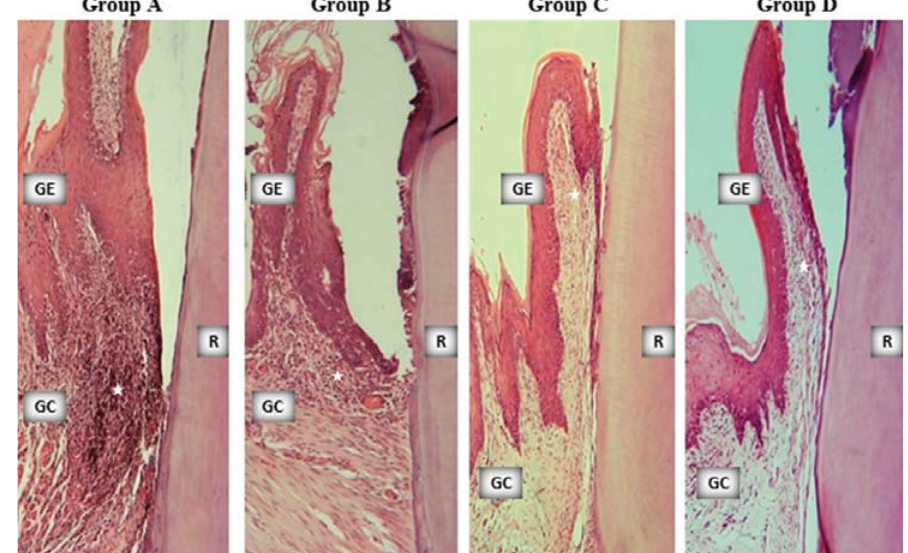
Figure 2- (cid:54)(cid:68)(cid:80)(cid:83)(cid:79)(cid:72)(cid:3)(cid:80)(cid:76)(cid:70)(cid:85)(cid:82)(cid:83)(cid:75)(cid:82)(cid:87)(cid:82)(cid:74)(cid:85)(cid:68)(cid:83)(cid:75)(cid:86)(cid:3)(cid:73)(cid:85)(cid:82)(cid:80)(cid:3)(cid:87)(cid:75)(cid:72)(cid:3)(cid:86)(cid:87)(cid:88)(cid:71)(cid:92)(cid:3)(cid:74)(cid:85)(cid:82)(cid:88)(cid:83)(cid:86)(cid:3)(cid:11)(cid:91)(cid:20)(cid:19)(cid:15)(cid:3)(cid:75)(cid:72)(cid:80)(cid:68)(cid:87)(cid:82)(cid:91)(cid:92)(cid:79)(cid:76)(cid:81)(cid:16)(cid:72)(cid:82)(cid:86)(cid:76)(cid:81)(cid:12)(cid:17)(cid:3)(cid:54)(cid:87)(cid:68)(cid:85)(cid:86)(cid:3)(cid:76)(cid:81)(cid:71)(cid:76)(cid:70)(cid:68)(cid:87)(cid:72)(cid:3)(cid:76)(cid:81)(cid:192)(cid:68)(cid:80)(cid:80)(cid:68)(cid:87)(cid:82)(cid:85)(cid:92)(cid:3)(cid:70)(cid:72)(cid:79)(cid:79)(cid:3)(cid:76)(cid:81)(cid:191)(cid:79)(cid:87)(cid:85)(cid:68)(cid:87)(cid:72)(cid:17)(cid:3)(cid:42)(cid:40)(cid:29)(cid:3) gingival epithelium, GC: gingival connective tissue, R: tooth Table 2- HScore values with the inter- and intra-group comparisons of IL-10 staining. Data were expressed as as mean±standart deviation (GE: Gingival epithelium; GC: Gingival Connective Tissue; PL: Periodontal Ligament)